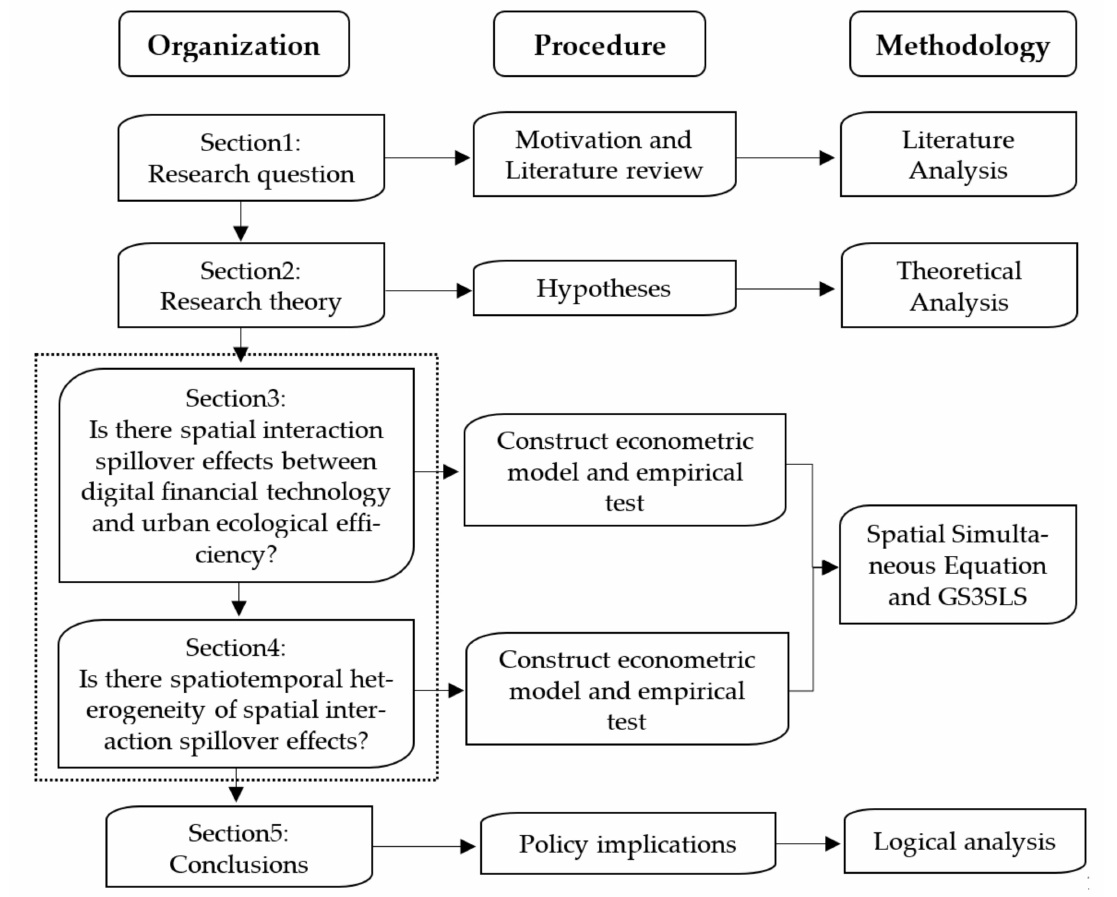
Figure 1. The logical framework of this